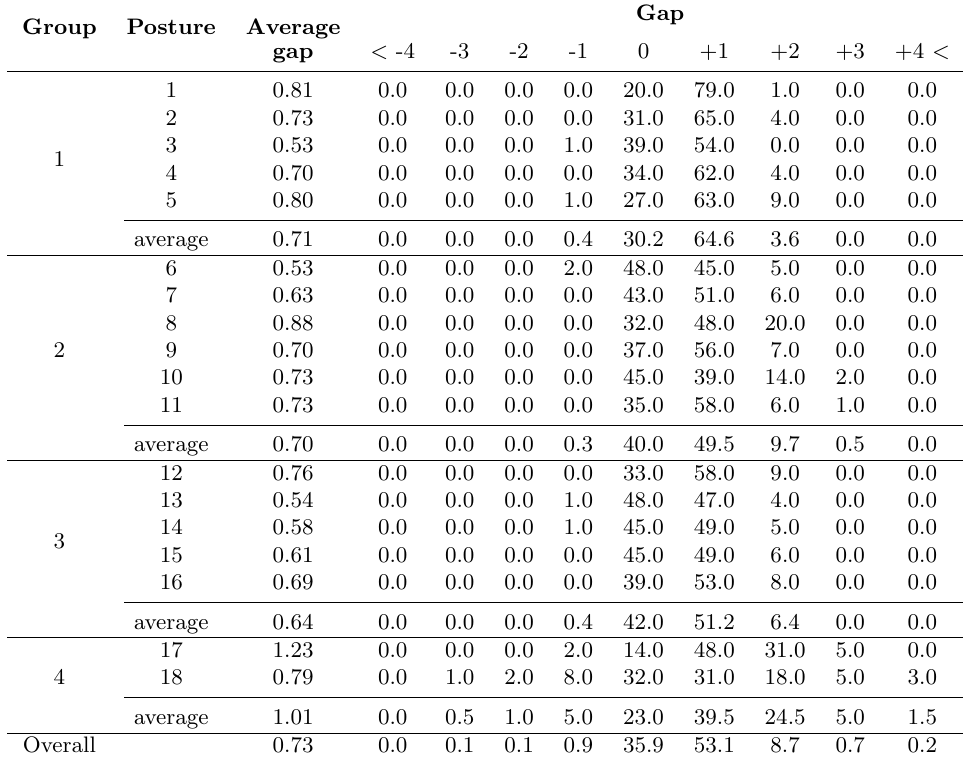
Table 5. The detail of the gap between the system’s judgments and the user expectations per posture [%].